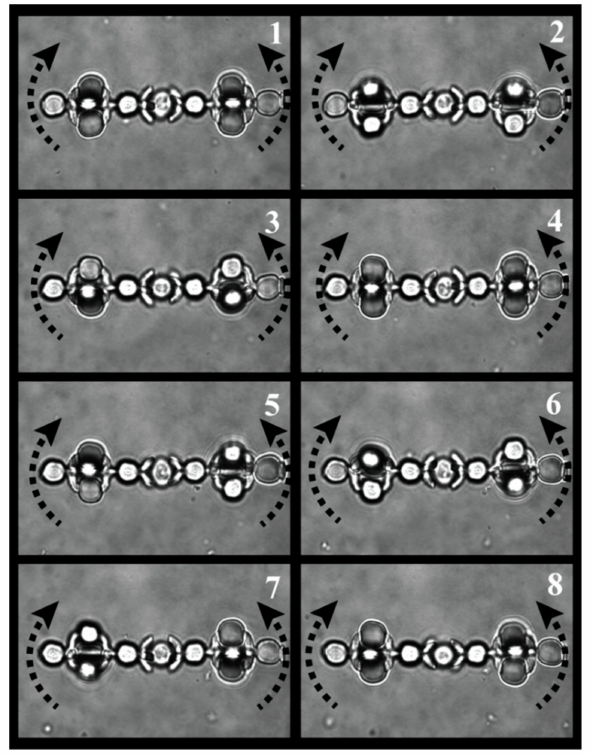
Figure 4. Frame sequence of rotation of trapped yeast cell. Frames were captured each